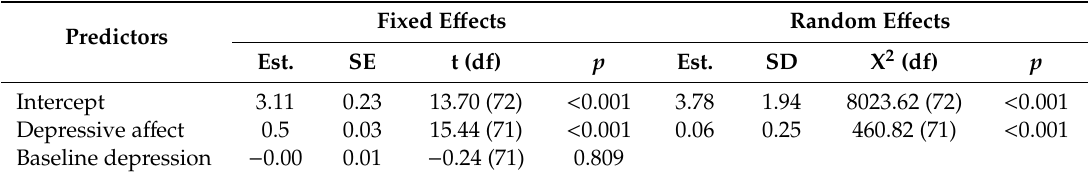
Table A6. Parameter estimates for multilevel model